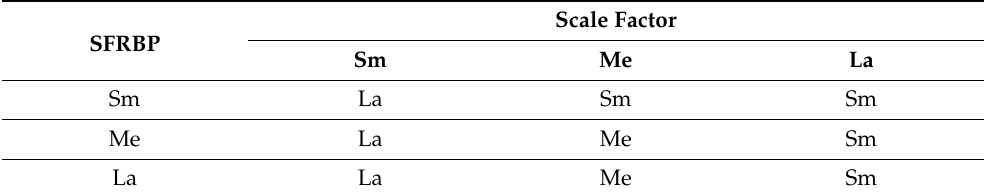
Table 1. Improved fuzzy rules.